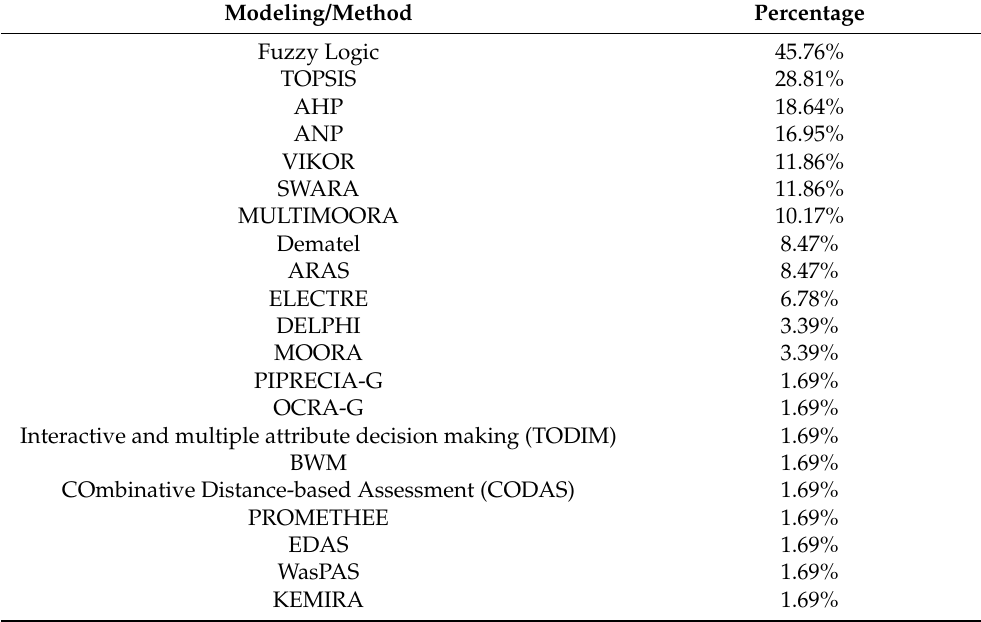
Table 1. Distribution of MCDM models and